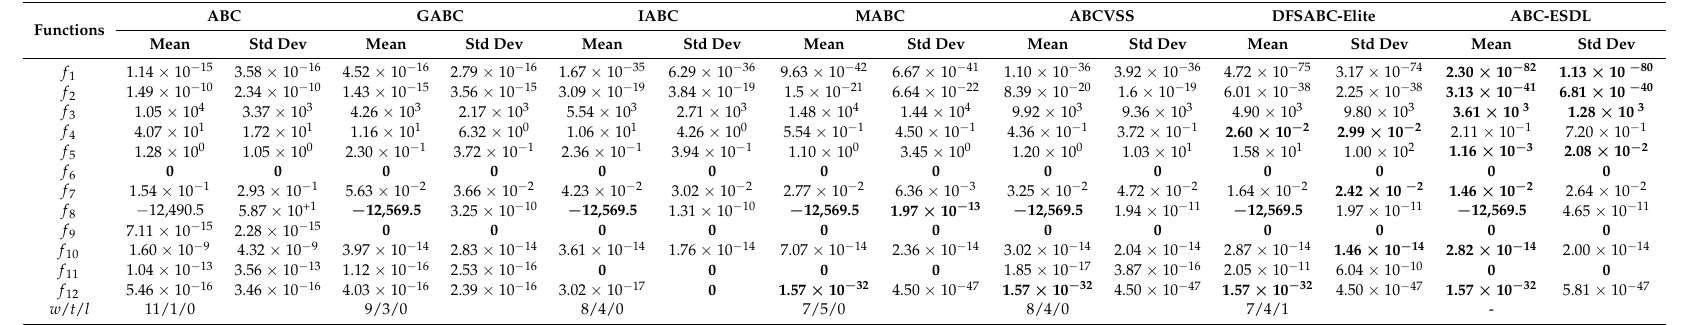
Table 2. Results of ABC-ESDL and six other ABC algorithms for D = 30.